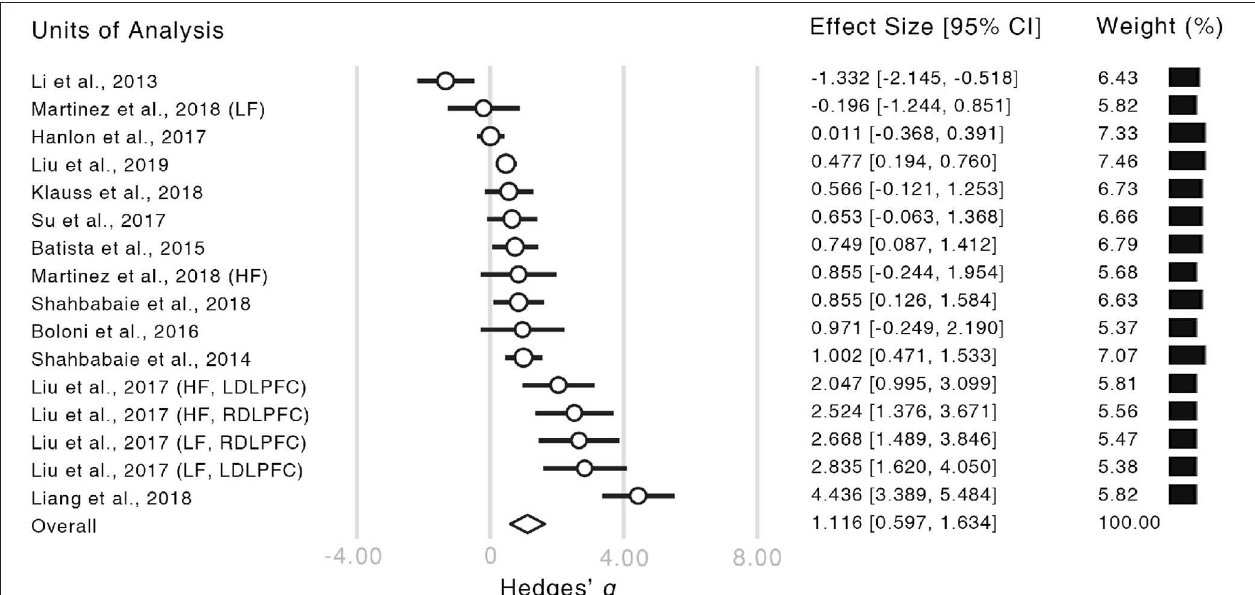
FIGURE 3 | Forest plot of the estimated effect sizes. Authors and years of publication of each unit of analysis are shown in the very left column. The words in the brackets indicate the information of within-study subgroups (HF, high frequency; LF, low frequency; LDLPFC, left dorsolateral prefrontal cortex; RDLPFC, right dorsolateral prefrontal cortex). In the forest plot, the length of each bar illustrates the confidence interval of the corresponding unit. The size of each empty circle illustrates the relative weight of each unit which is also showed by the black bars on the right-hand